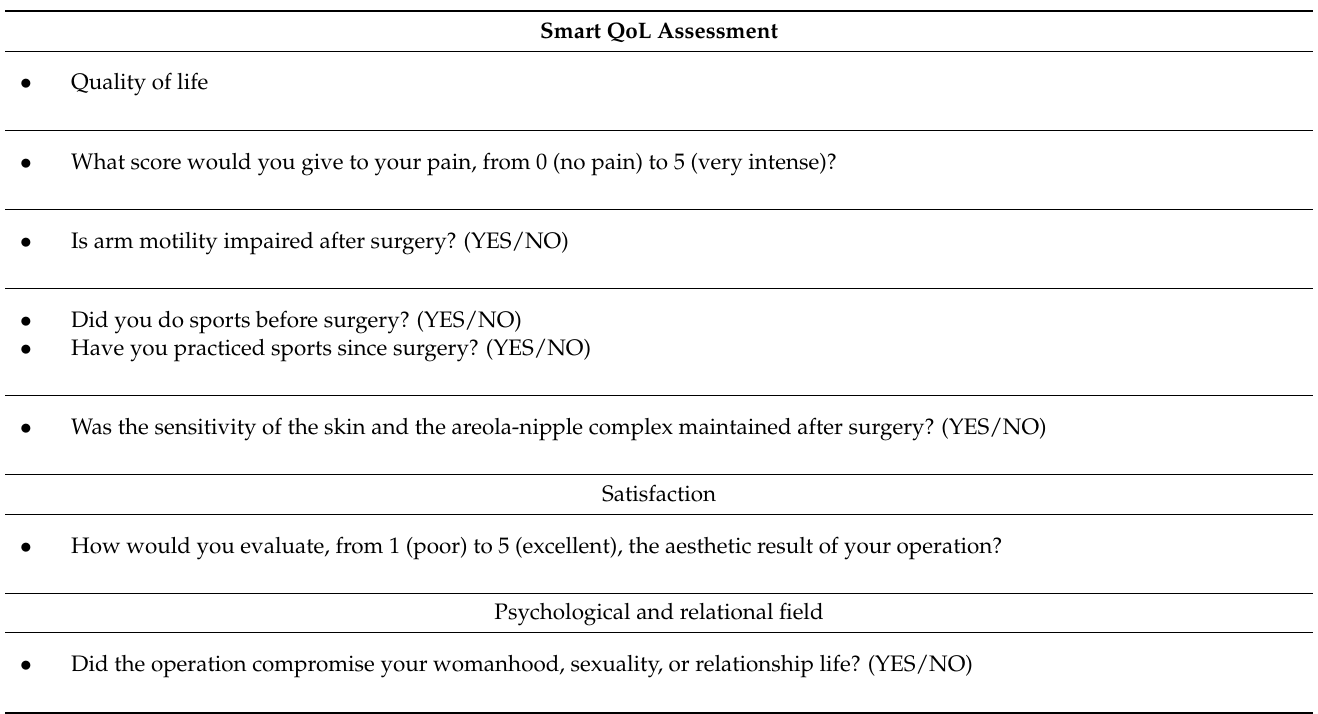
Table 1. QOL assessment PRO